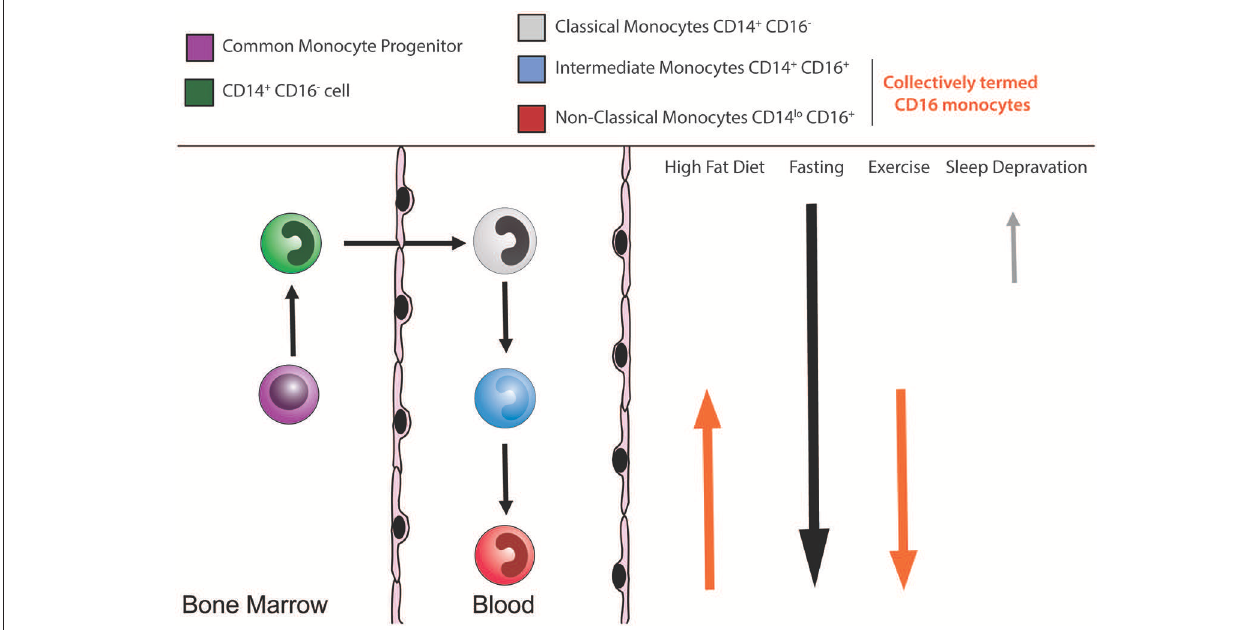
FIGURE 1 | Human monocyte subsets. Circulating monocytes arise in the bone marrow from a common monocyte progenitor (cMoP) before being released into the peripheral circulation. The circulating monocyte pool is composed of multiple subsets. Human CD14 + CD16 − classical monocytes (gray), CD14 + CD16 + intermediate monocytes (blue), and CD14 lo CD16 + non-classical monocytes (red). Several external lifestyle factors can impact on these monocyte